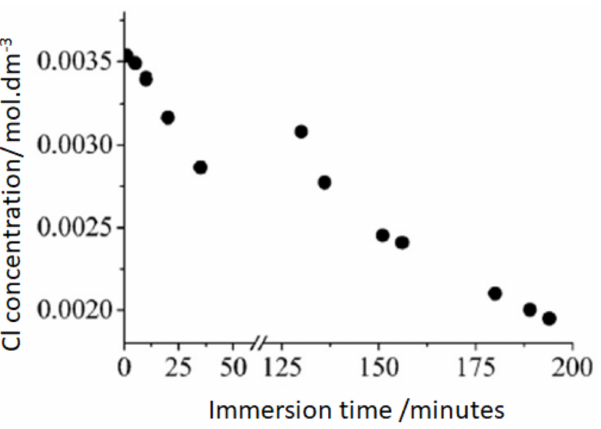
Figure 15. Evolution of chloride concentration in NaCl solution during 200 min of immersion of mi- croparticles, with V/P ratio = 40. Reprinted with permission from Ref. [64]. Copyright 2013,